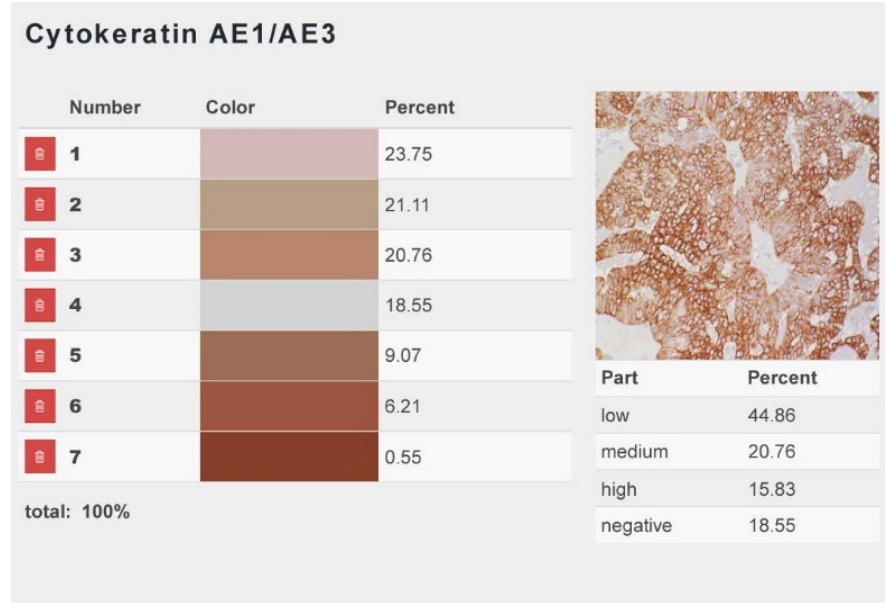
Figure 1. Web application for the detection of the immunopositive areas, specifically designed for the present study. For each uploaded image, the immunopositive areas with low (numbers 1 and 2), moderate (number 3), and high staining intensity (numbers 5, 6, and 7), as well as the immunonegative area (number 4), are calculated. The results are provided as percentages of the entire analyzed area. Exemplarily depicted is an uploaded image from a pet rabbit mammary carcinoma immunostained for cytokeratin AE1/AE3. The total immunostained area encompasses 88.45%.